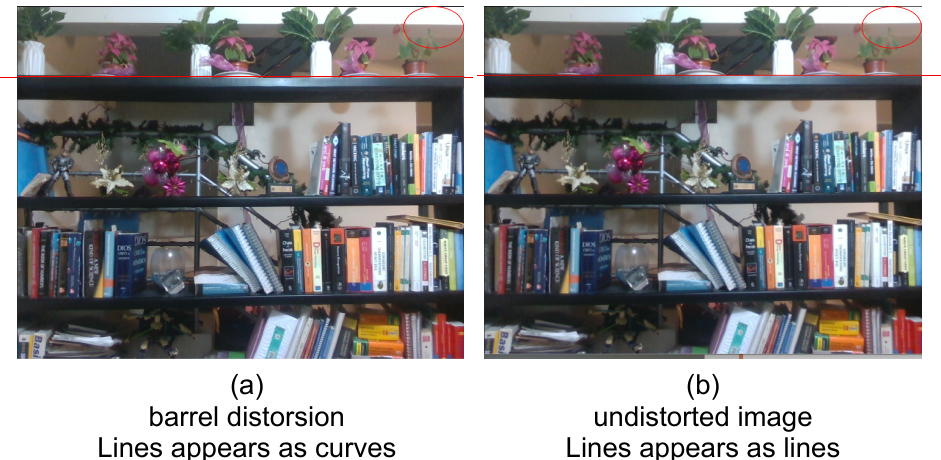
Figure 3. Barrel distortion appears at the left of the image. The main characteristic of this type of distortion is straight lines appearing as curves with the outer side from the center to the edges of the image ( a ). On the right side ( b ), the same scene image after an undistortion correction [31]. When aligning both layers to correspond to textures from the color layer with 3D objects in the depth layer, some areas and/or objects do not show only their textures, but appear misaligned, mixing other texture regions from other objects in the scene [31] (Figure 4).